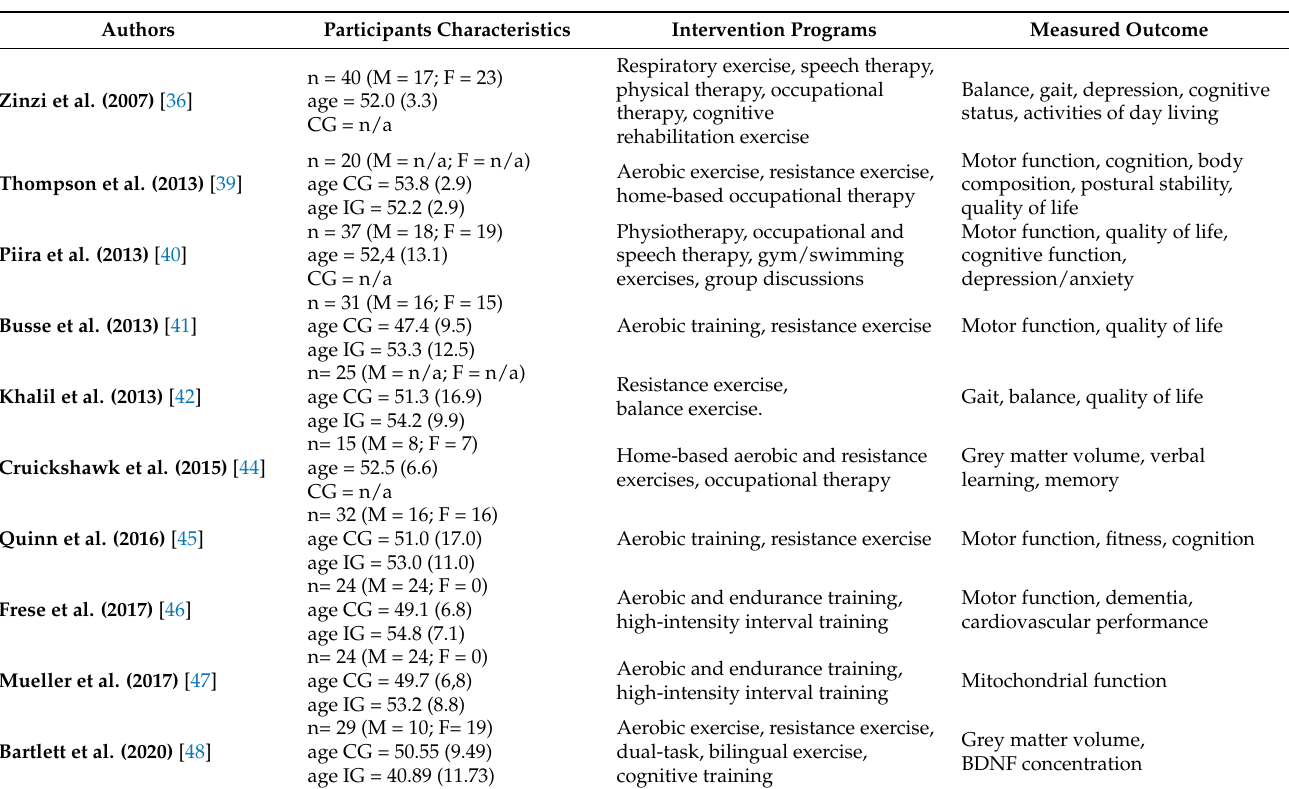
Table 2. Overview description of physical activity interventions. CG: control group; IG: intervention group; n/a= not